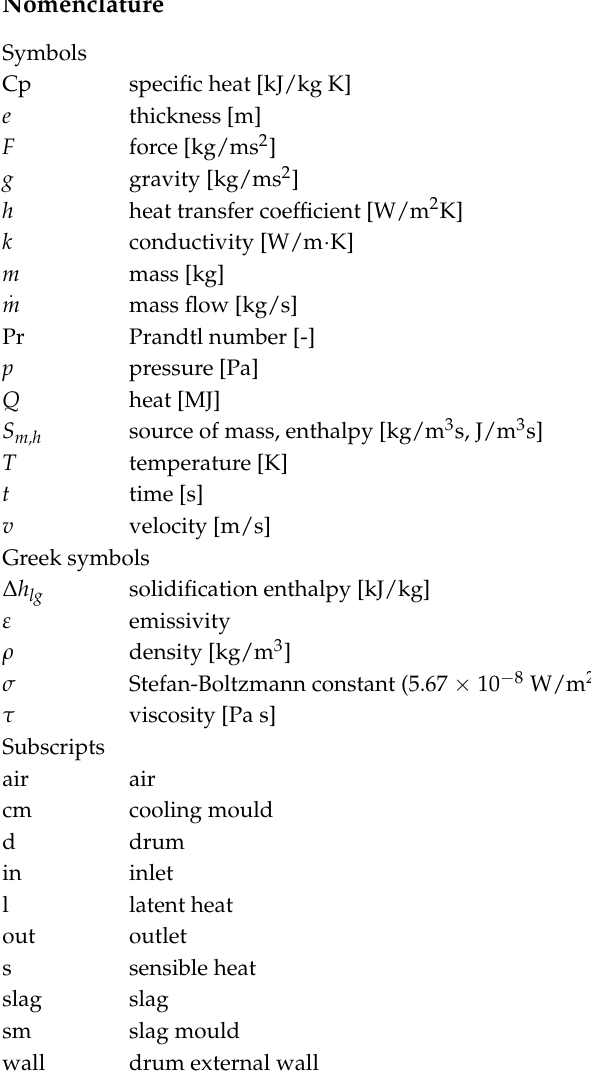
s1, Table S1: Average heat transfer coefficient for each drum position, for the matrix of air flow velocities and drum wall